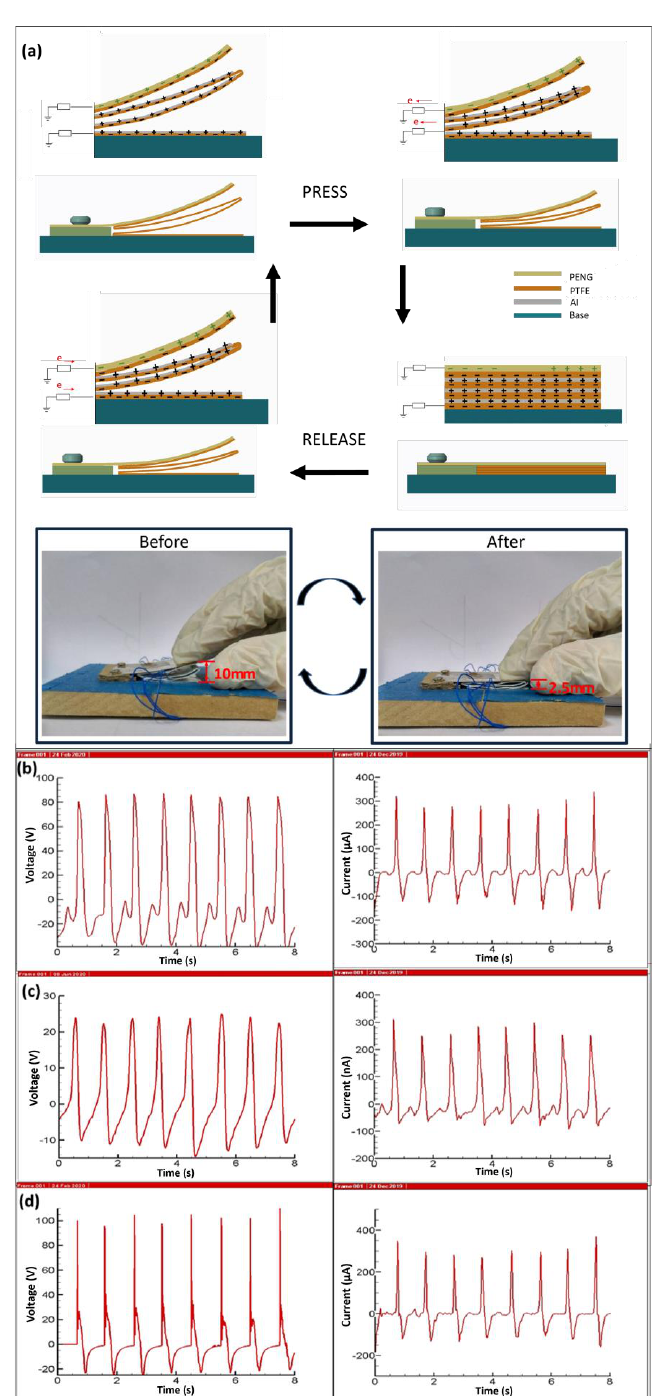
Figure 2. ( a ) Working mechanism of the proposed SPMS whose piezoelectric and triboelec- tric charge generation and electricity generation processes can be described by the compres- sion/deformation/touch/release processes. ( b ) The open-circuit voltage (OCV) and short-circuit current (SCC) of the triboelectric generators (TENG) with the PTFE film and Al film touch/release processes with an accumulated displacement ~0.35 mm were ~84 V and 300 µ A, respectively. ( c ) The OCV and SCC of the piezoelectric device with an accumulated displacement ~5 mm was ~22 V and 285 nA, respectively. ( d ) The OCV and SCC of the superposition integrated SPMS were ~103 V and 302 µ A,